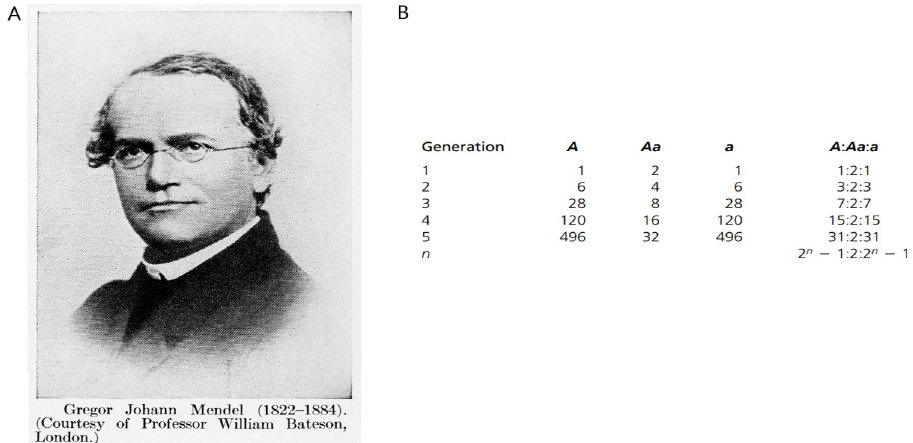
Fig 1. Gregor Mendel—teacher and scientist. (A) A portrait of Gregor Mendel (1822–1884). Credit: Wellcome Collection. Attribution 4.0 International (CC BY 4.0). (B) Mendel´s model expressed in terms of ratios [5,6].